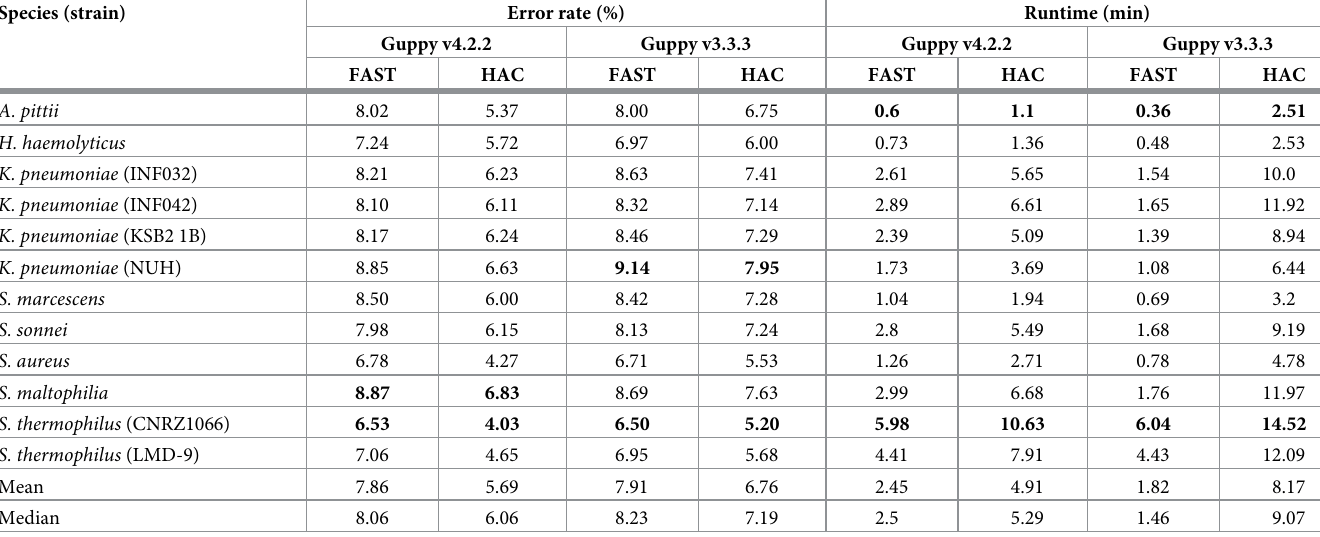
Table 2. Global error rate and runtime for bacterial species, in FAST and HAC basecalling modes, comparing versions 3.3.3 and 4.2.2 of Guppy. Species (strain)